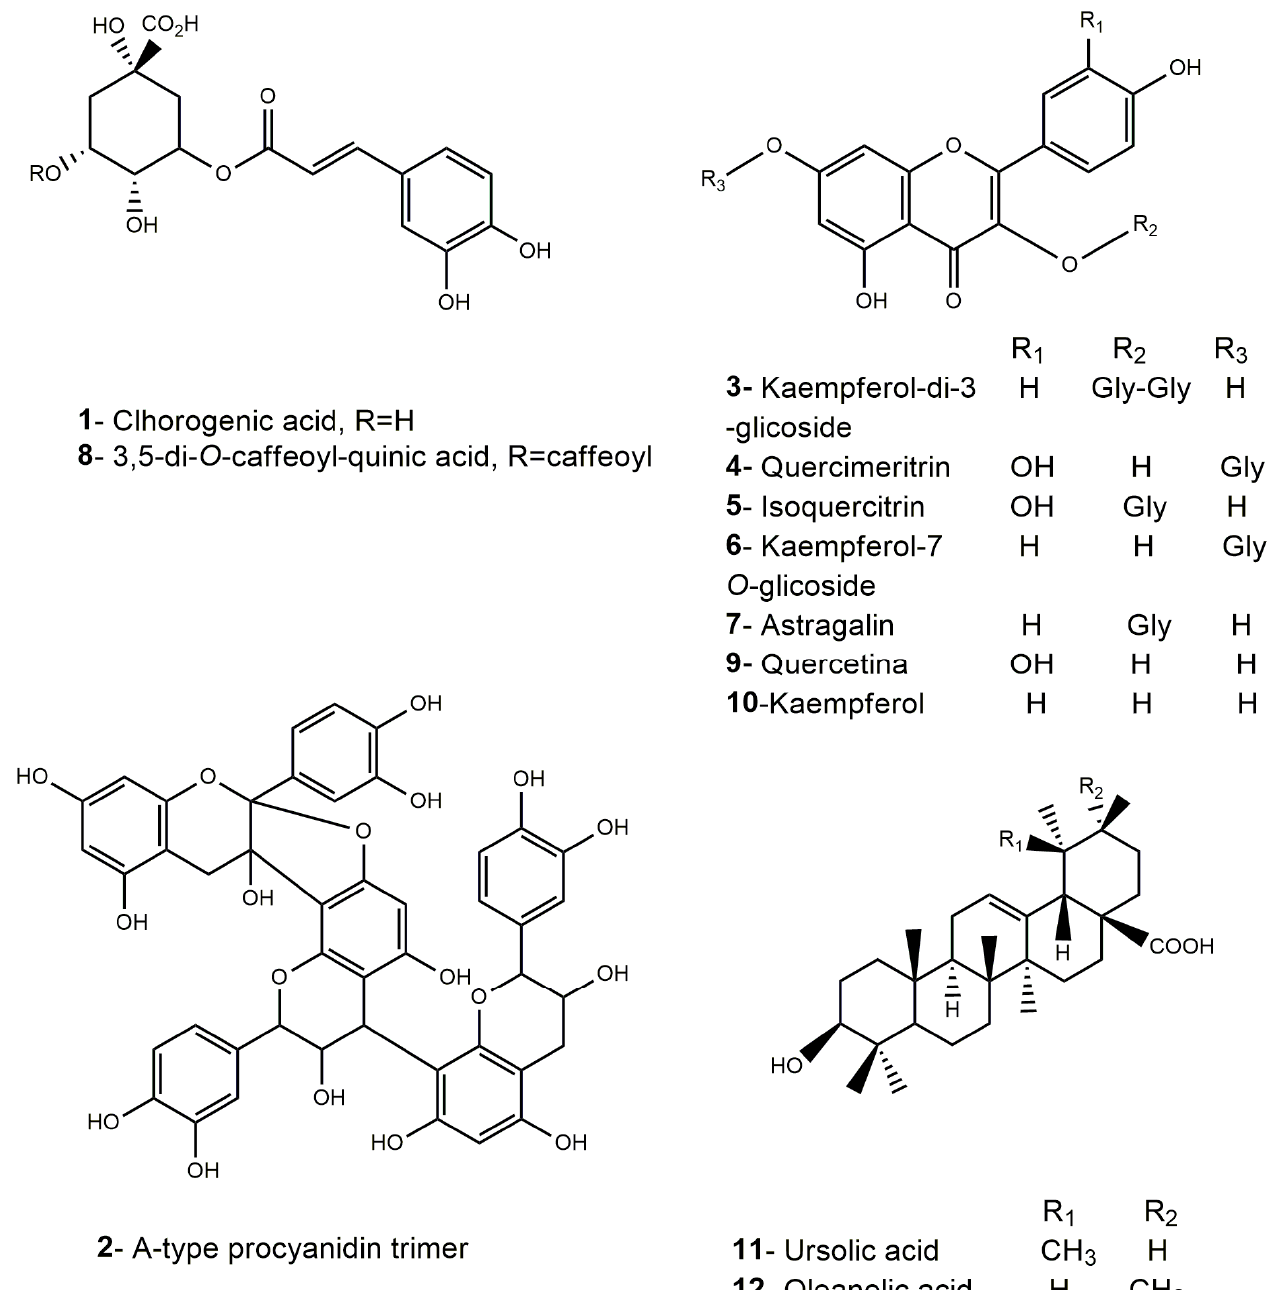
Figure 3. Chemical structures (1–12) of the compounds identified in MMEAF subfractions.